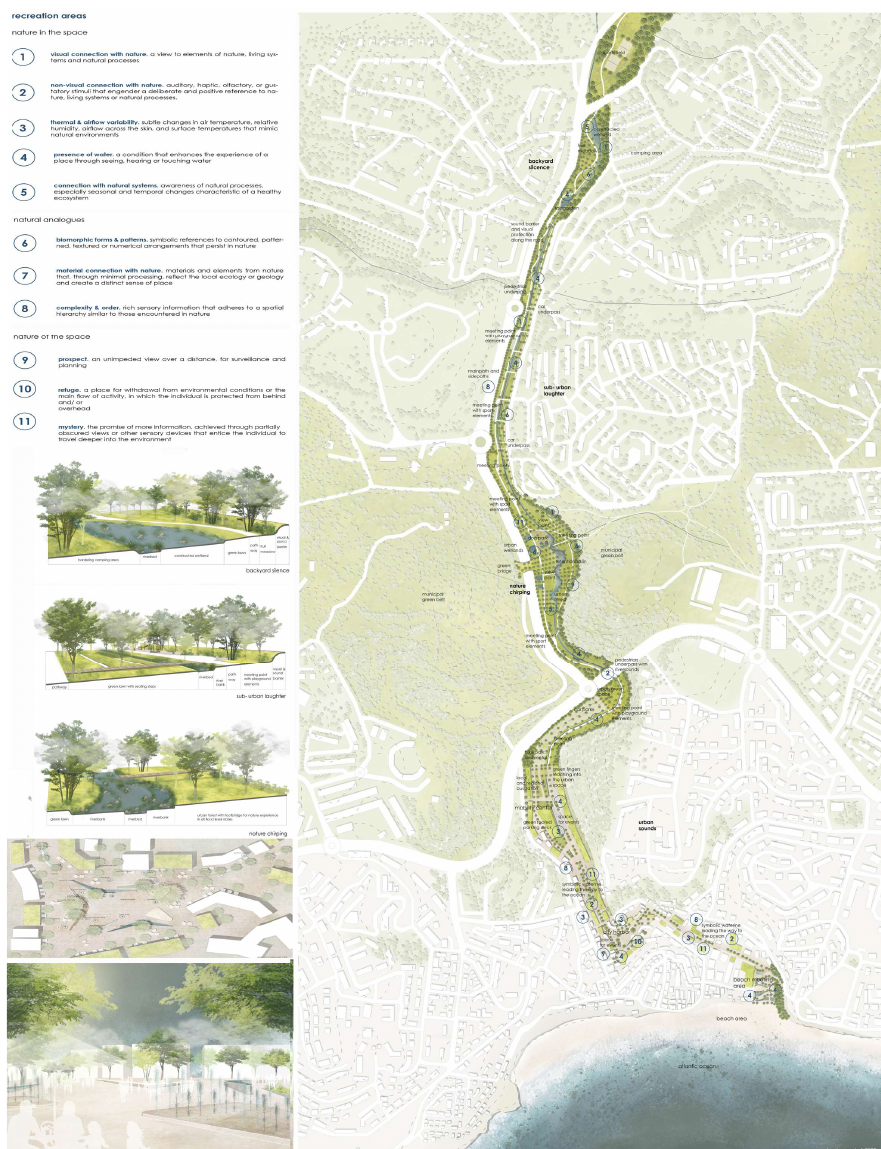
Figure 7. The urban river recovery inspired by nature-based solutions and biophilic design in Albufeira, Portugal. Perspectives from the four zones derived from the scrolling method and the city centre symbolic lagoon.